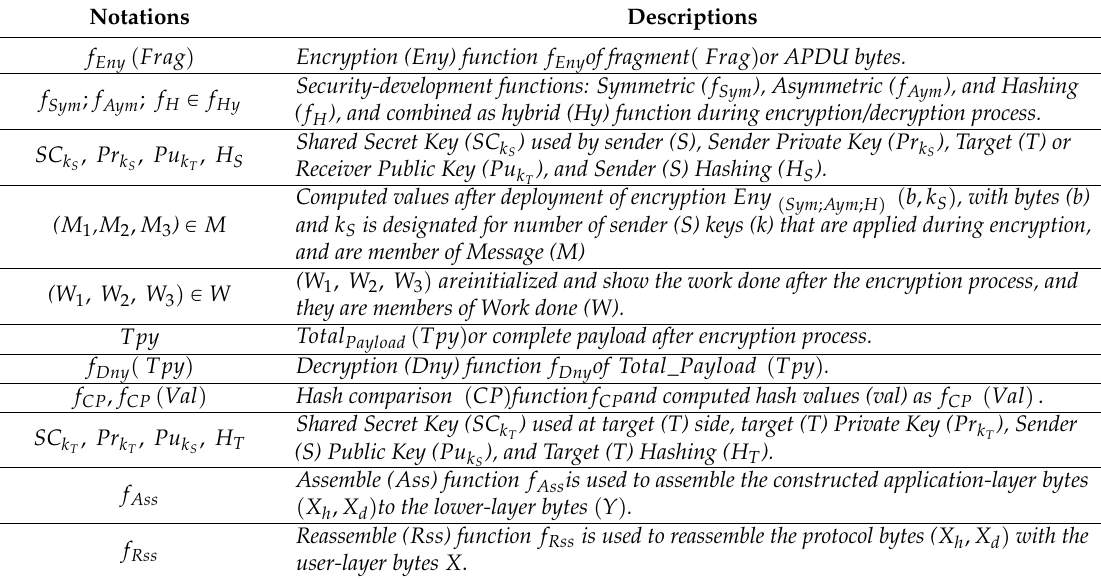
Table 2. Terminologies for security